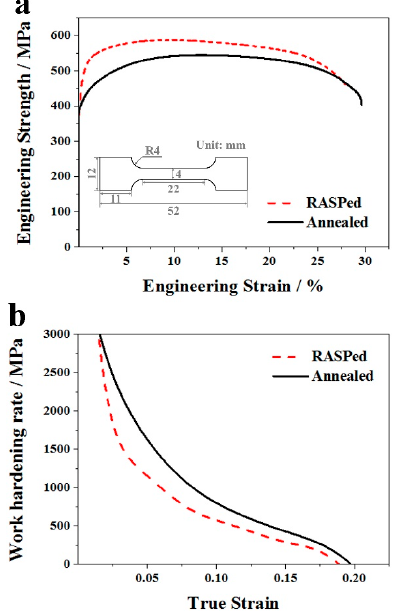
Figure 5. ( a ) Engineering stress-strain curves, and the size of the “dog bone” shape tensile sample is shown, ( b ) strain hardening rate ( θ = d σ /d ε ) versus the true strain of as-annealed Ti and RASP-processed Ti.